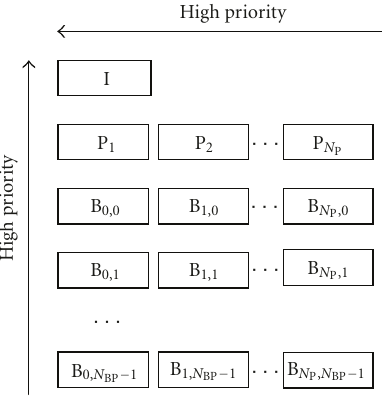
Figure 6: Video frame classification within a